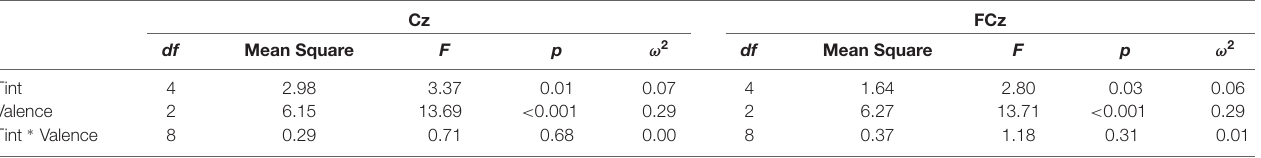
TABLE 2 | ANOVA of LPP (500–1,500 ms) in detail.